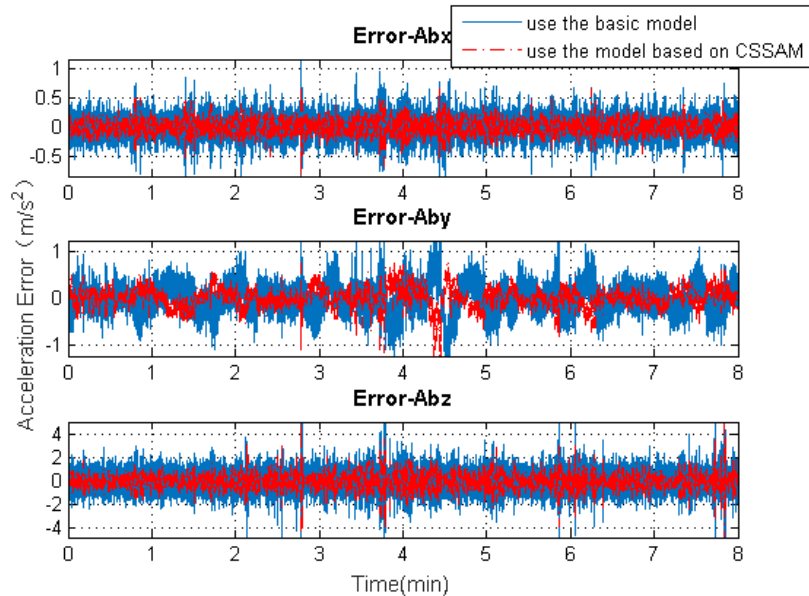
Figure 11. The 3D acceleration solution accuracy comparisons using the basic model or the model based on the CSSAM.